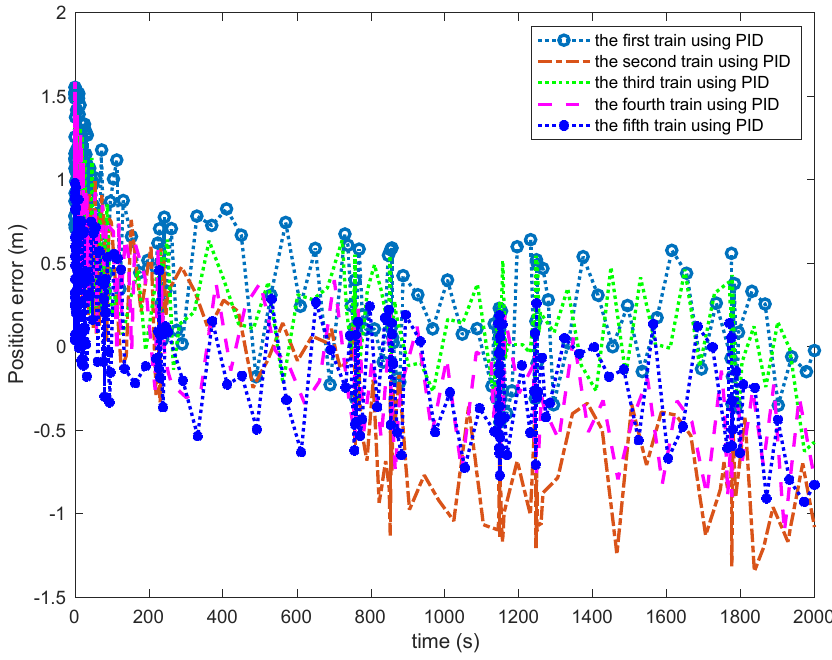
Figure 13. Position tracking error curves of PID controller.